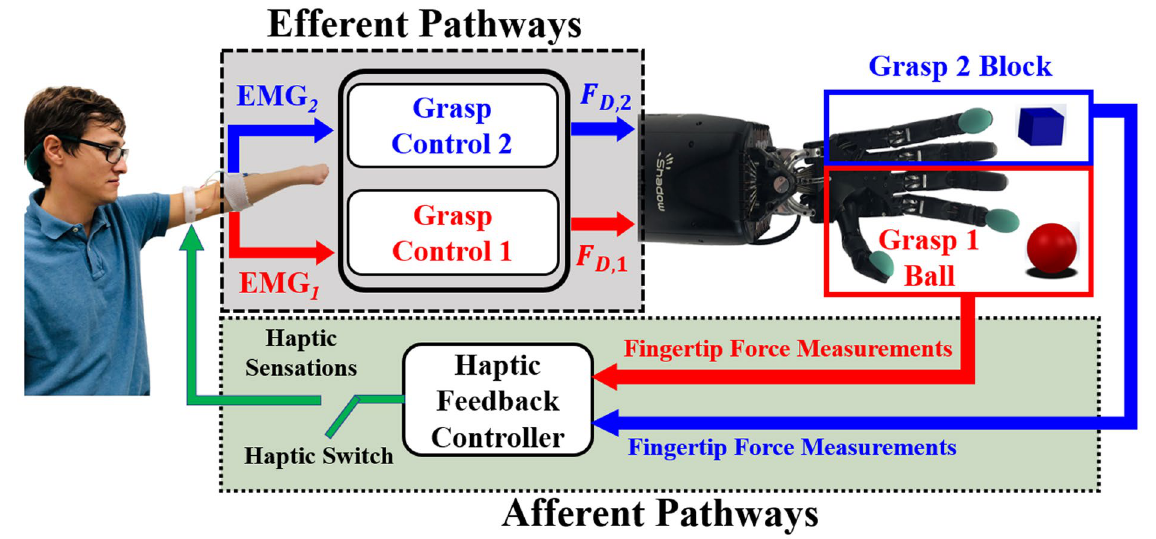
Figure 1. Subjects used two EMG signals (efferent pathways, top) to simultaneously control the distinct grip forces applied to two different objects (top right), in a combinatorial experimental plan with and without haptic (bottom panel) and/or visual feedback. The study demonstrates that multiple channels of bimodal haptic feedback enabled successful grasp and transportation of both objects simultaneously even when vision of the objects was completely occluded [subject’s photograph used with